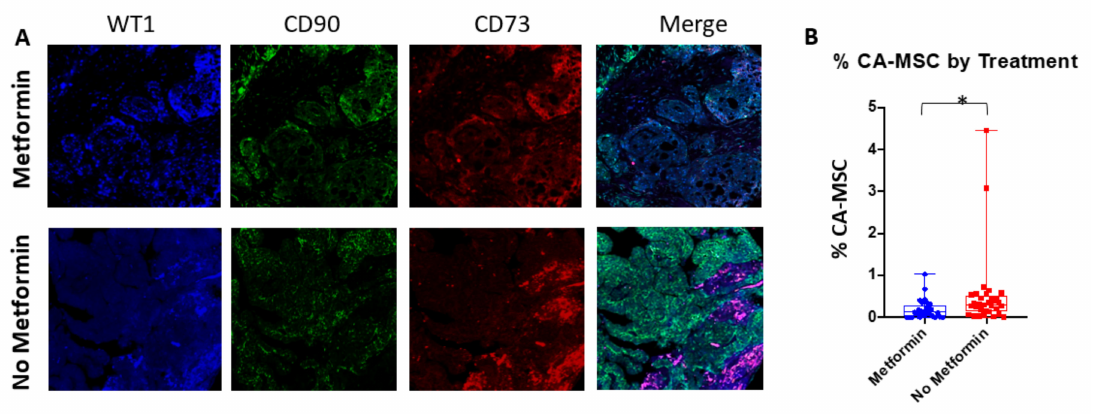
Figure 1. Treatment with metformin is associated with decreased number of CA-MSC. ( A ) Repre- sentative confocal microscopy immunofluorescent images of metformin-treated and non-metformin- treated human samples (10 × ). Overlays of CD73 (red), CD90 (green), and WT1 (blue) identify CA-MSCs (magenta). ( B ) Quantification of CA-MSCs for available tissue samples. CA-MSCs reported as a percentage of the total tissue area. * indicates statistical significance at p <